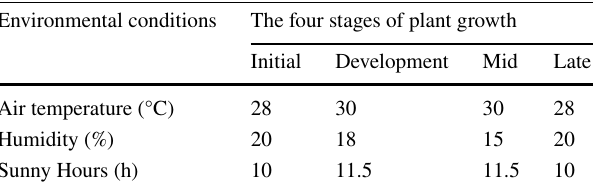
Table 2 The average amount of environmental conditions in the four stages of plant